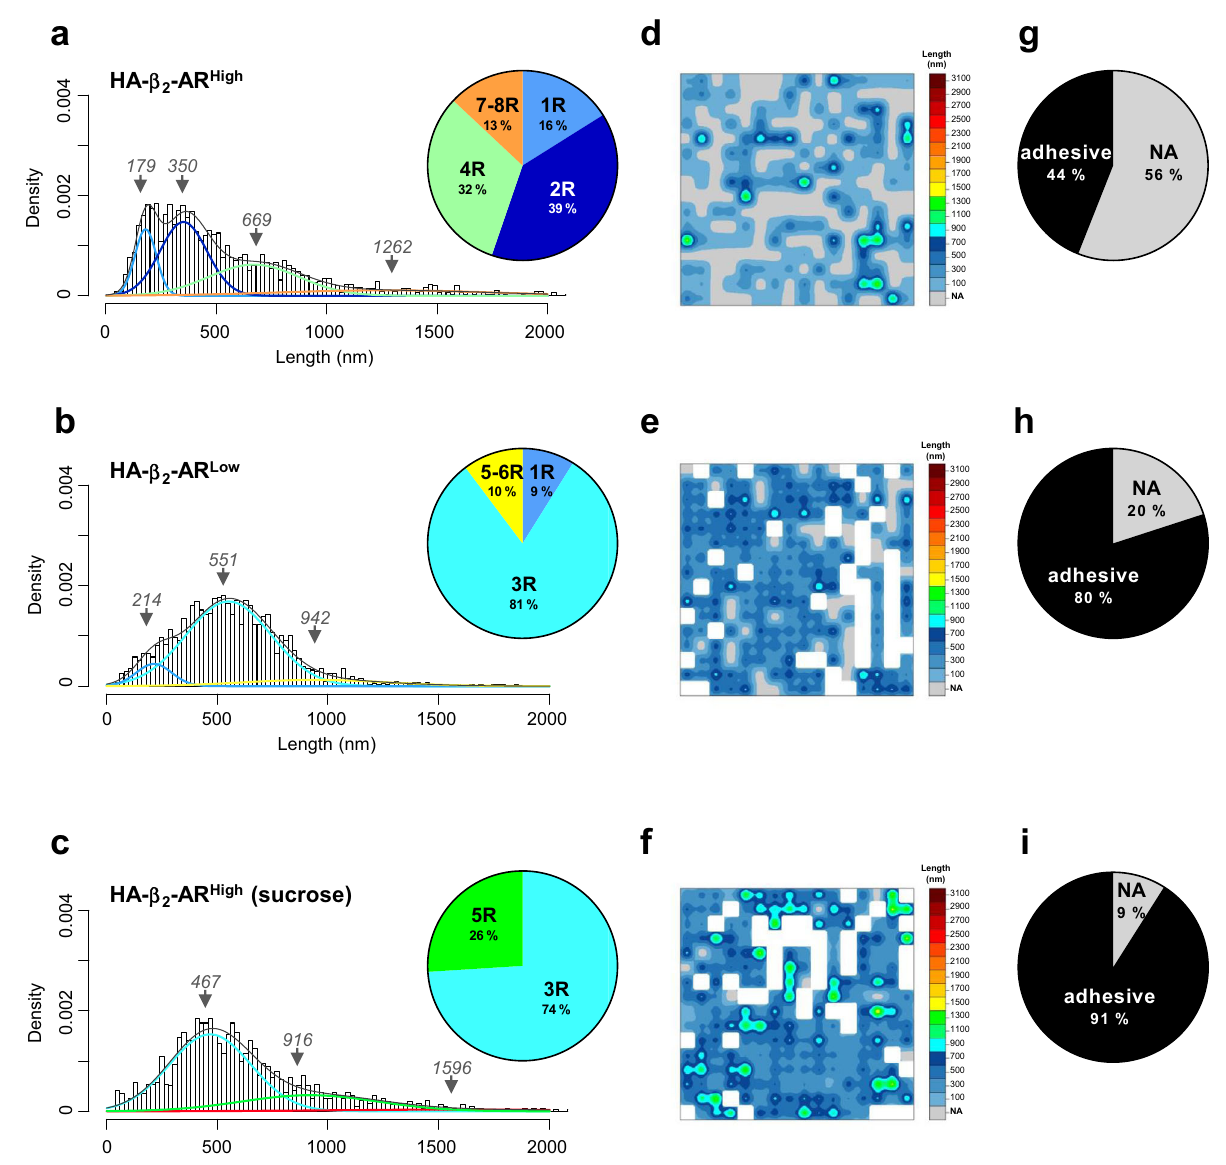
Fig. 5 Correlating the GPCR constitutive activity with their oligomerization and spatial organization using FD-based SMFS. SMFS experiments were conducted on WTT-CHO cells transiently transfected with 1 µ g of vector encoding HA- β 2 -AR (HA- β 2 -AR High ) treated ( c , f , i ) or not ( a , d , g ) with 200 mM sucrose for 1 h or with 0.1 µ g of HA- β 2 -AR-encoding vector (HA- β 2 -AR Low ) ( b , e , h ). Unfolding distances were analyzed by fi tting with a Gaussian mixture according to the BIC-based method. Each Gaussian population was assigned to a GPCR oligomeric state ( 1 receptor/monomer = 1 R; 2 receptors/dimer = 2 R; 3 receptors/trimer = 3 R … ) based on their theoretical length, and Gaussian weight is presented in the pie charts ( a , b , c ). The 256 unfolding distances resulting from one representative cell area (3 × 3 µ m 2 ) are depicted as a spatial map ( d , e , f ). The proportions of adhesive and non-adhesive (NA) events are shown in the pie charts ( g , h , i ). For each condition, at least nine cells from at least three independent experiments were analyzed. Note that a , d , g are similar to Fig. 4a, e, i to facilitate